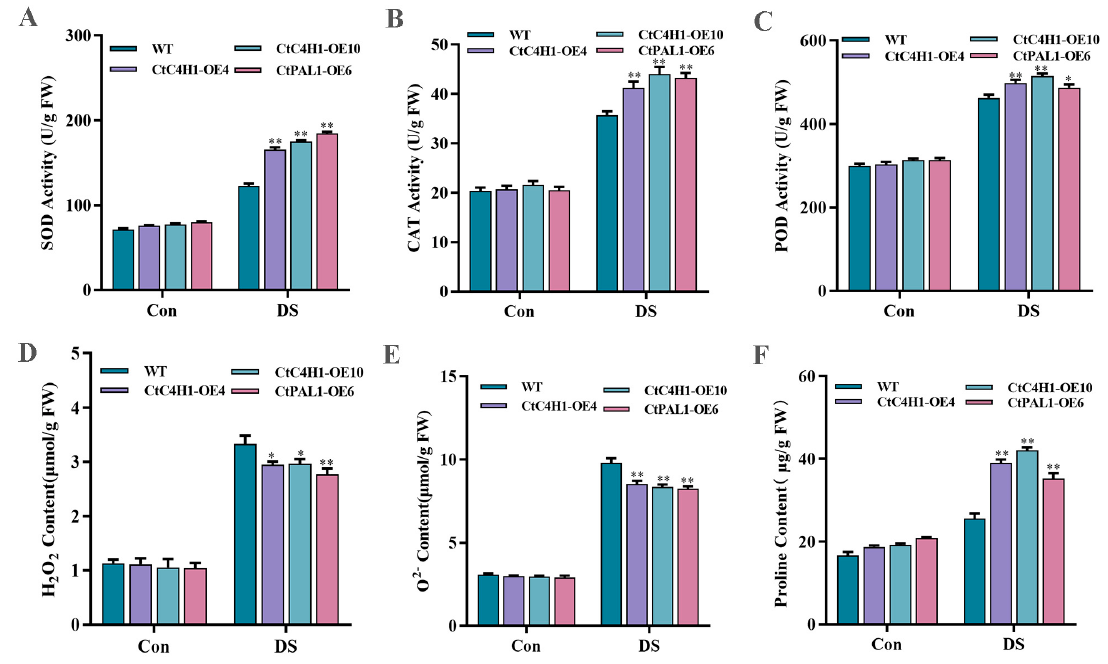
Figure 9. Determination of antioxidant enzymes activities and related physiological indexes of CtPAL1 and CtC4H1 transgenic plants after drought stress treatment. ( A ) Superoxide dismutase activity (SOD). ( B ) Catalase activity (CAT). ( C ) Peroxidase activity (POD). ( D ) H 2 O 2 content analysis. ( E ) O 2 − content analysis. ( F ) Proline content analysis. The numerical value represents the average ± standard deviation of three biological repetitive samples. The statistics were calculated with one- way ANOVA test and significant differences between treatments were demonstrated with asterisk (* p < 0.05, ** p < 0.01).